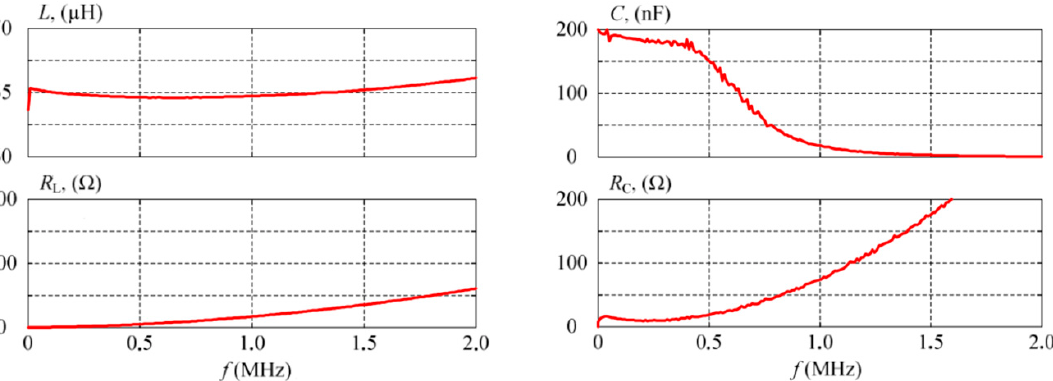
Figure 4. Measured inductance, resistance of the filter inductor, capacitance and its series equivalent resistance of the filter capacitor.